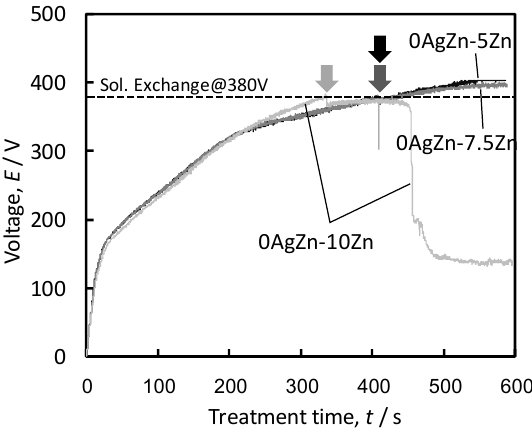
Figure 2. Voltage changes during two-step MAO treatment under different second step conditions of Zn concentration. The black and gray arrows indicate when the voltage reached 380 V and the solution was exchanged.